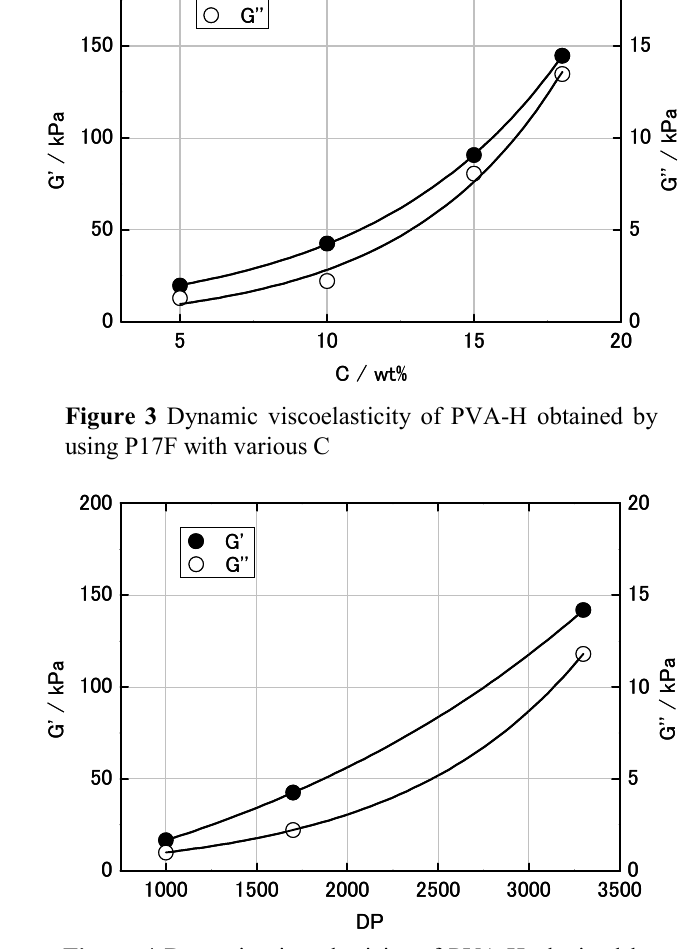
Figure 4 Dynamic viscoelasticity of PVA-H obtained by using PVA (C = 10 wt%) with various DP